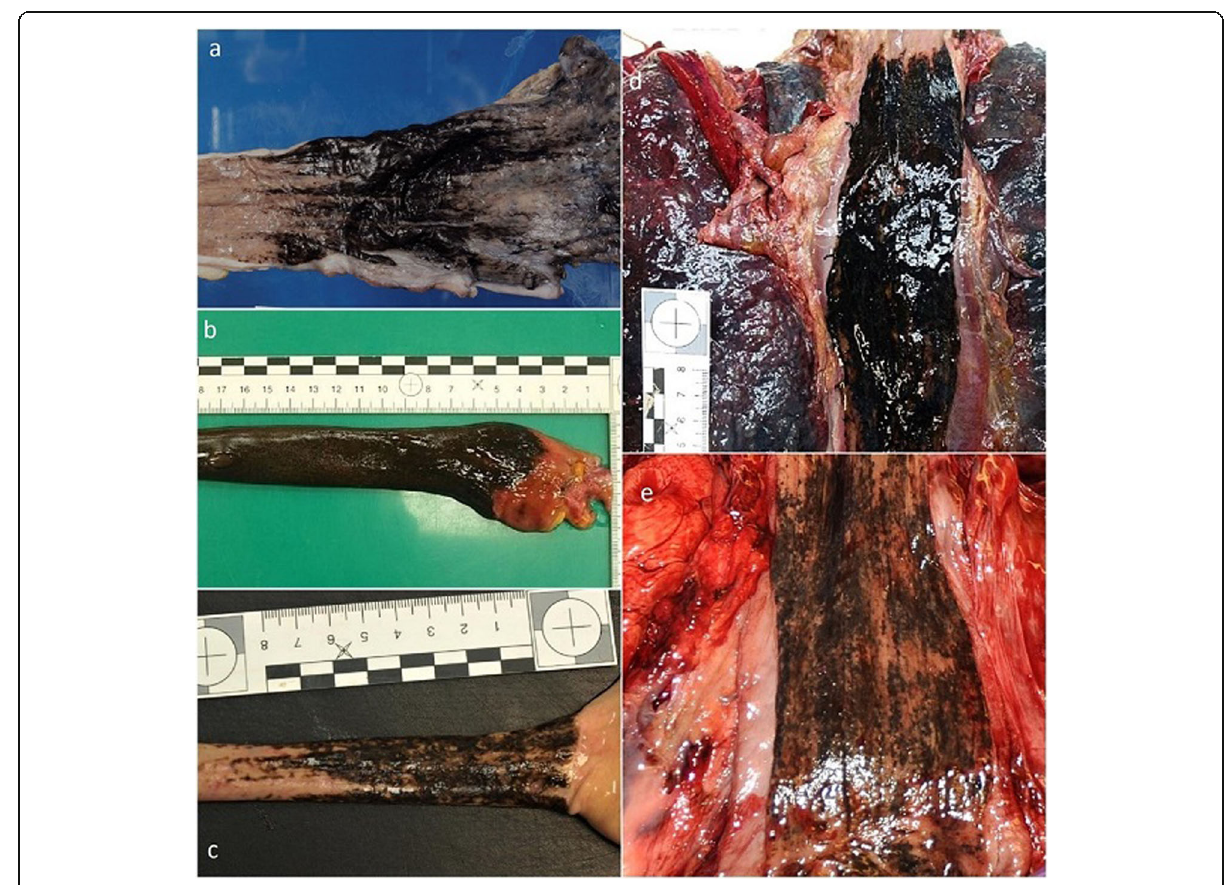
Fig. 1 Gross appearance of black esophagus discovered at autopsy. The pictures of the case series ( a – e ) illustrate the circumferential blackish discoloration of esophageal mucosa over a various length. b and c highlight the sharp ending of black esophagus at gastroesophageal junction (esophagus was turned inside out without opening in b and e